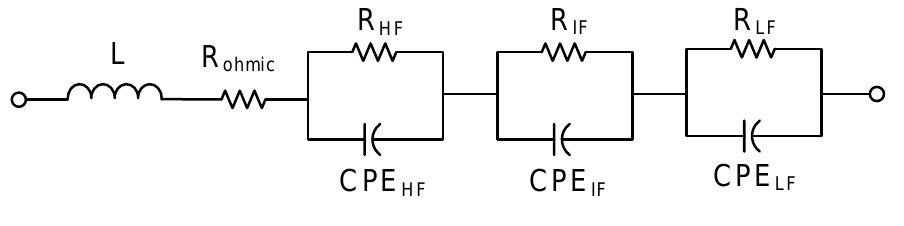
Figure 3. The equivalent circuit model used in this